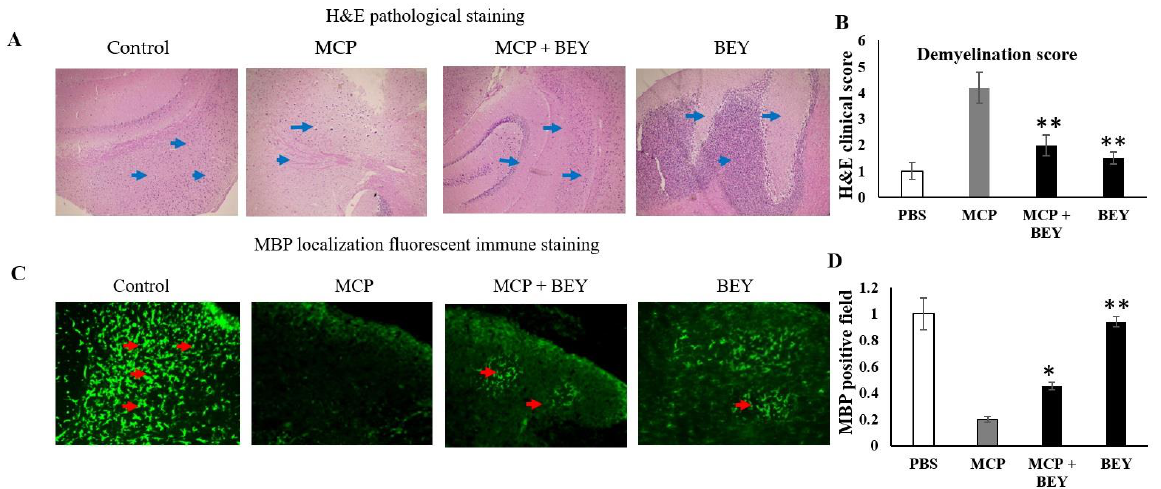
Figure 4. BEY augmented the histopathological condition in the CNS of EAE mice. On the 27th day of MOG immunization, EAE mice were sacrificed, and their spinal cords were extracted and fixed in formaldehyde (10%), followed by paraffin embedding and preparation of 4 µm-thick sections. ( A ) Spinal cords were assessed for demyelination using H&E, and the pathological parameters were noted at 200X resolution. ( B ) Demyelination, infiltration and inflammation scores were recorded. ( C , D ) Immunofluorescence quantification of MBP to evaluate myelin sheath damage after 16 days of MOG induction. MBP is indicated by a green fluorescence. The myelin damage in the subcortical white matter of spinal cord was alleviated in BEY group at 27 days of MOG induction. We repeated three independent experiments to extract the data and represented the results as mean ± SD; * significant at * p ≤0.05, ** p ≤ 0.01 .